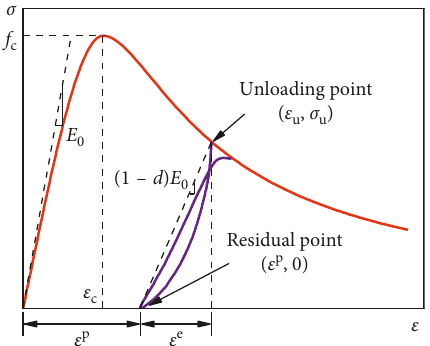
Figure 11: Typical stress-strain curve of the RAC under cyclic loading.